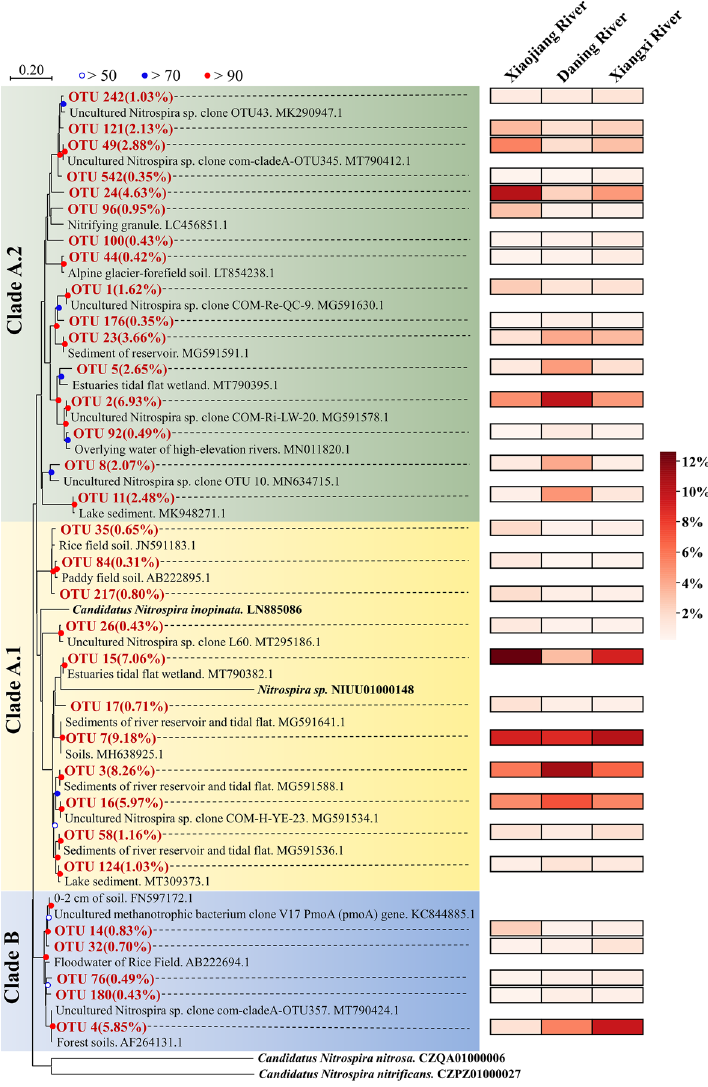
Figure 6. Neighbor-joining phylogenetic tree and relative abundances of Comammox Nitrospira amoA gene sequences. The reference sequences are from the GenBank. The sequence and its corresponding sequence number (consisting of the letters and numbers, behind sequence) are listed in a row. Percentages in brackets following the OTUs indicate the percentage of each OTU in the total comammox amoA gene sequences. The calculation method of neighbor-joining phylogenetic tree is Maximum Composite Likelihood, and the scale bar (on the top) represents 20% sequence